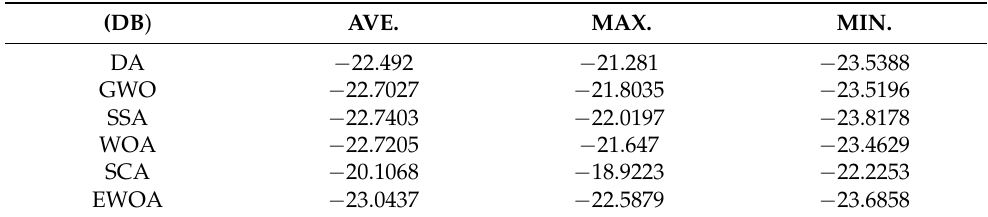
Table 5. Statistical results of the objective values obtained by different approach in the case with 10 populations and 440 elements.